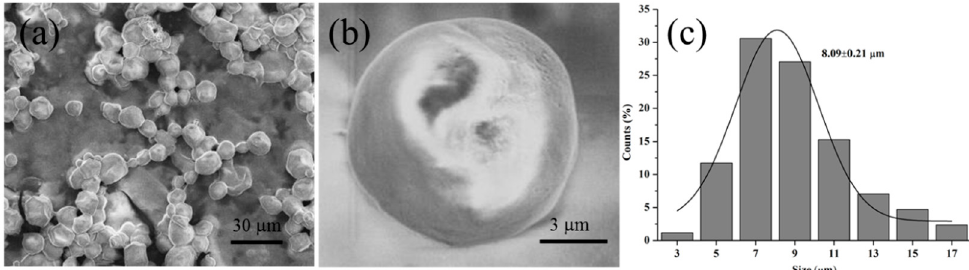
Figure 3. SEM morphological analysis of CS/CMS-lysozyme microspheres: ( a ) overview, ( b ) enlarged image of the individual capsule and ( c ) histograms of size distribution. The solid line in the size histograms is the simulation curve of Gaussian distribution. The data outlined refer to the most probable size.